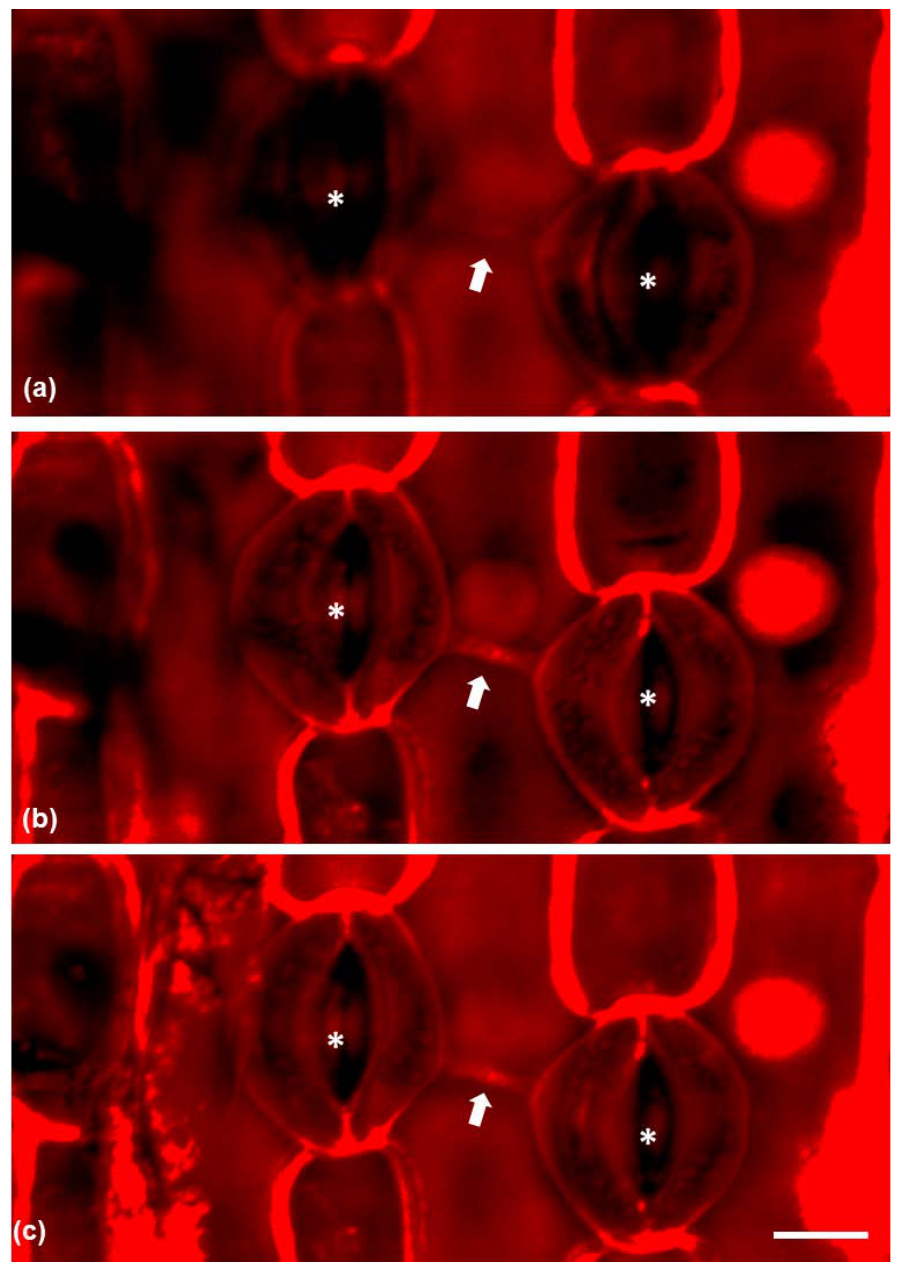
Figure 5. CLSM micrographs of epidermal peels stained with propidium iodide, depicting connected stomata (asterisks) and the connection strand between them (arrow). ( a ) CLSM section on the external region of the epidermal cell between the stomata. ( b ) A median CLSM section and ( c ) CLSM maximum projection. Scale bar: 20 μm.